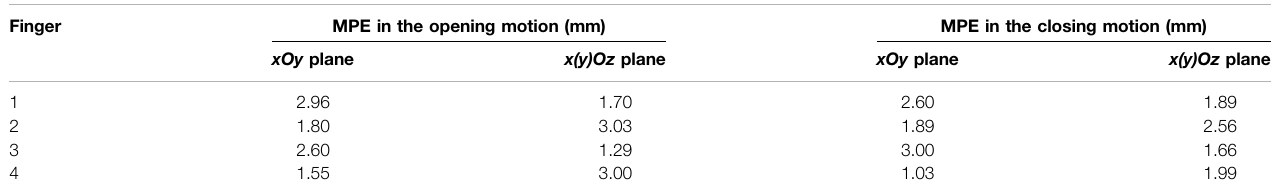
TABLE 1 | Maximum position error (MPE) of fi ngertips in the 2D plane.